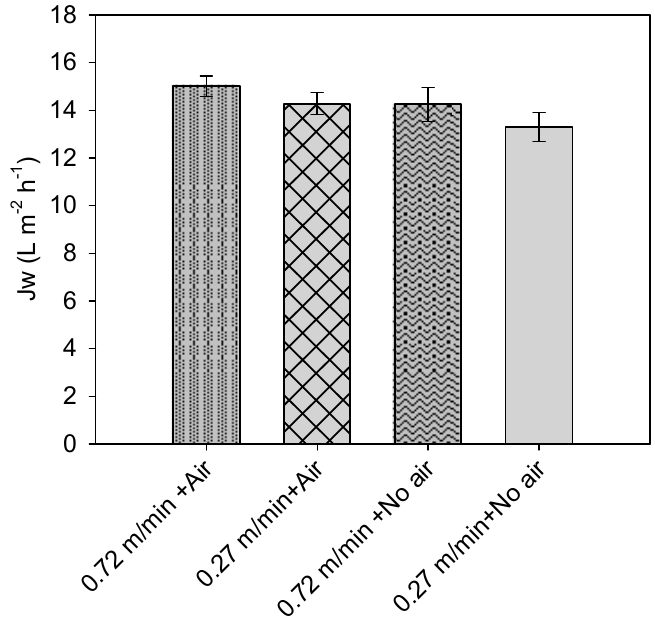
Figure 3. Impact of crossflow velocity (CFV) and an air sparging application on the average initial water flux (first 10 min of operation).